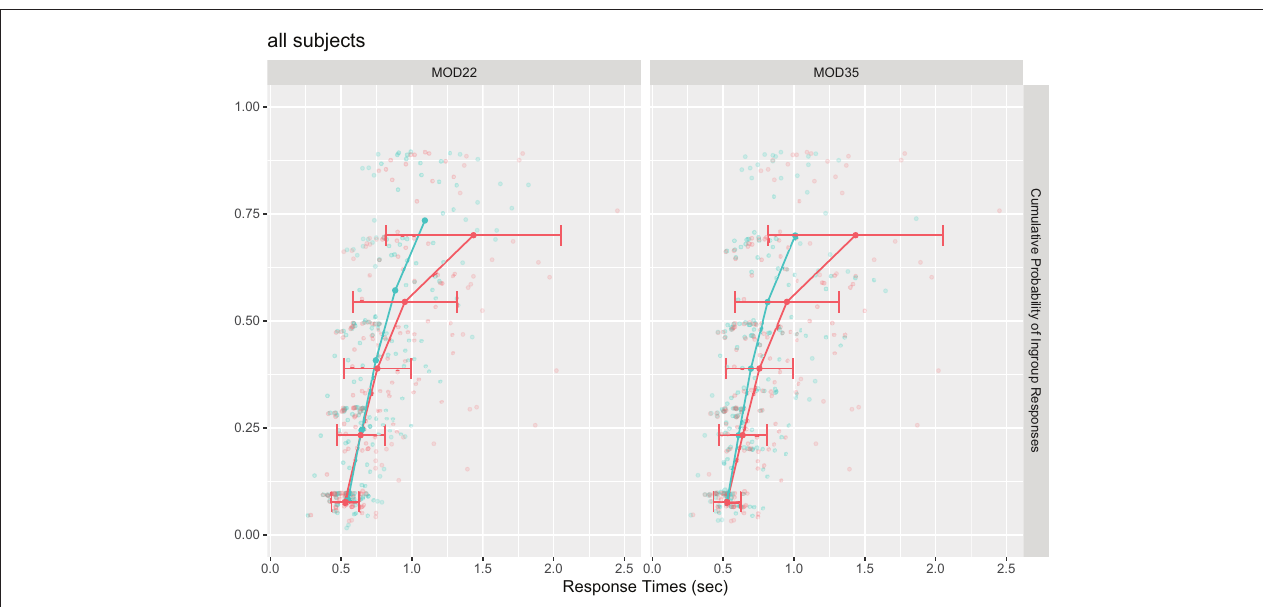
FIGURE 3 | Cumulative Distribution Function Plot—predicted (red) vs. observed (blue) responses for model 22 and 35; quantiles per subject aggregated; only ingroup responses; lines represents 0.10th, 0.30th, 0.50th, 0.70th, 0.90th aggregated quantiles; dots are individual quantiles; standard deviation as error bar; red: observed data; blue: predicted